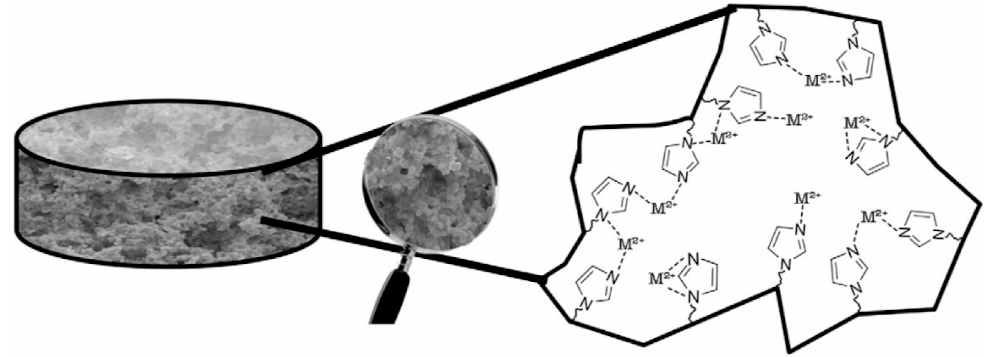
Figure 8. Scheme of the pre-complex formation between imidazole groups and metal ions. Republished with permission of Elsevier, from [49]; permission conveyed through Copyright Clearance Center, Inc.